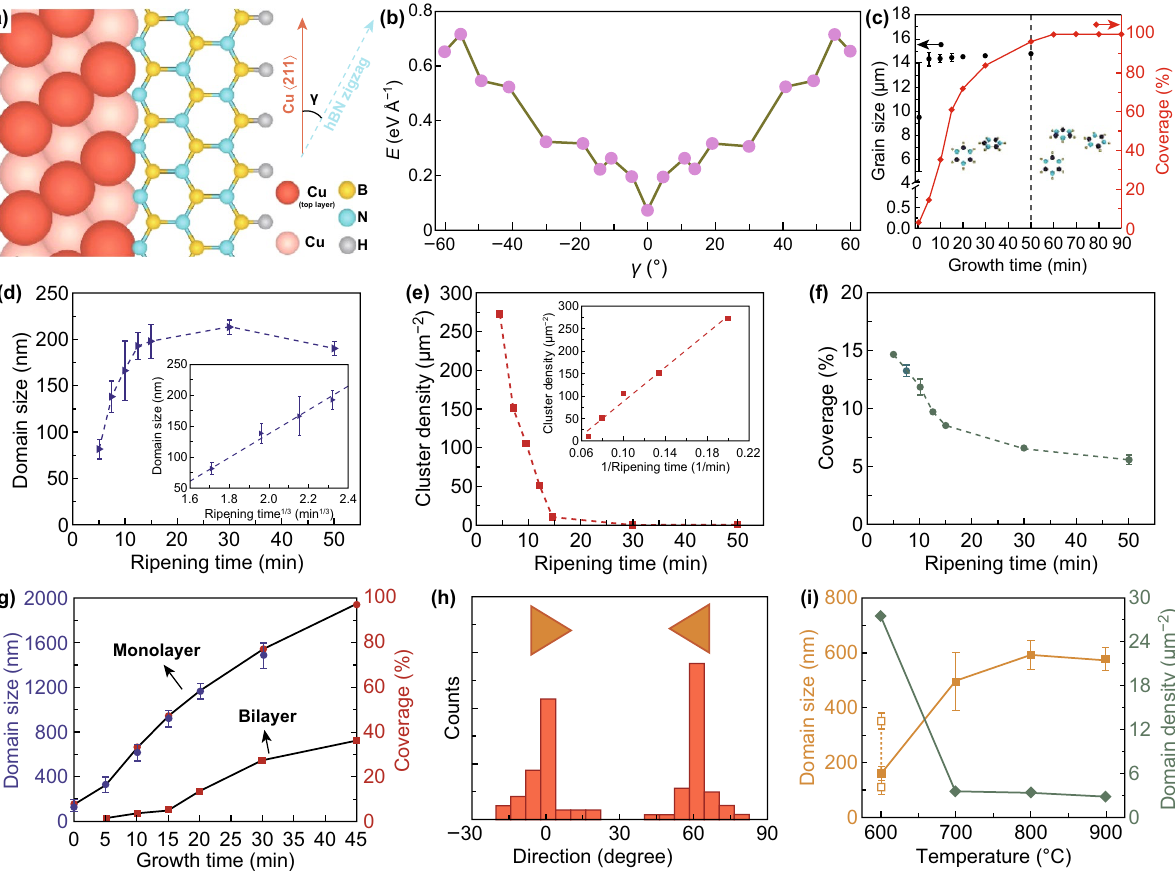
Fig. 19 Strategies for enhancing crystal domain sizes. a Effect of the amount of precursor on nucleation and growth during CVD synthesis of MoS 2 to provide optimum crystal domain size. Adapted with permission from Ref. [25]. Copyright 2017, Wiley. b , c Oxygen-assisted CVD growth of MoS 2 leads to an increase in domain size in 30 min; however, domains start to etch away if growth time is increased further. Adapted with permission from Ref. [56]. Copyright 2015, ACS Publications. d – f Diffusion-controlled growth of WSe 2 by optimising ripening step show- ing domain size, cluster density and substrate coverage as a function of ripening time. g , h Effect of growth step time on area coverage high- lighting the domain direction statistics. i Effect of substrate temperature on domain size and density. Adapted with permission from Ref.